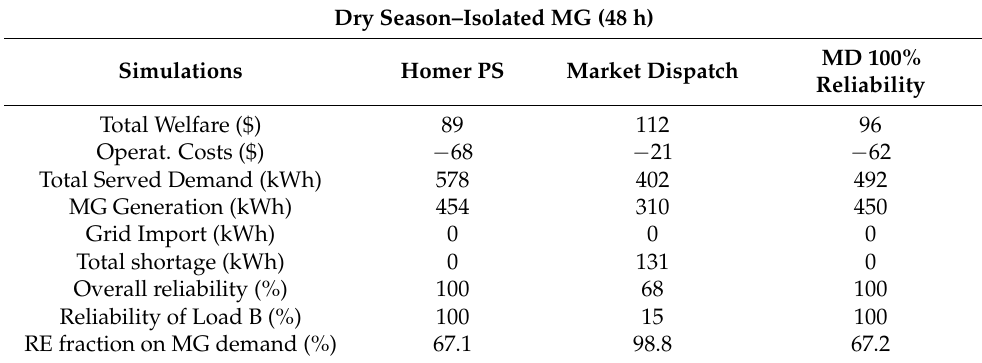
Figure 21. Market–based optimal dispatch for dry season off-grid mini-grid with extra reliability constraint for load B. Table 6. Comparison table for simulation results under the dry season isolated